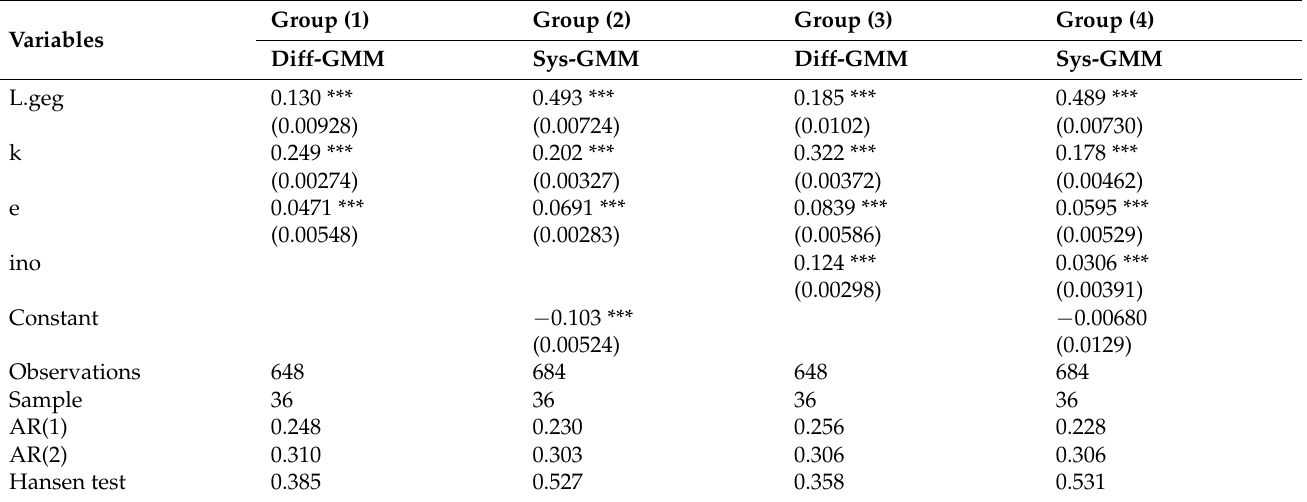
Table 5. The production function